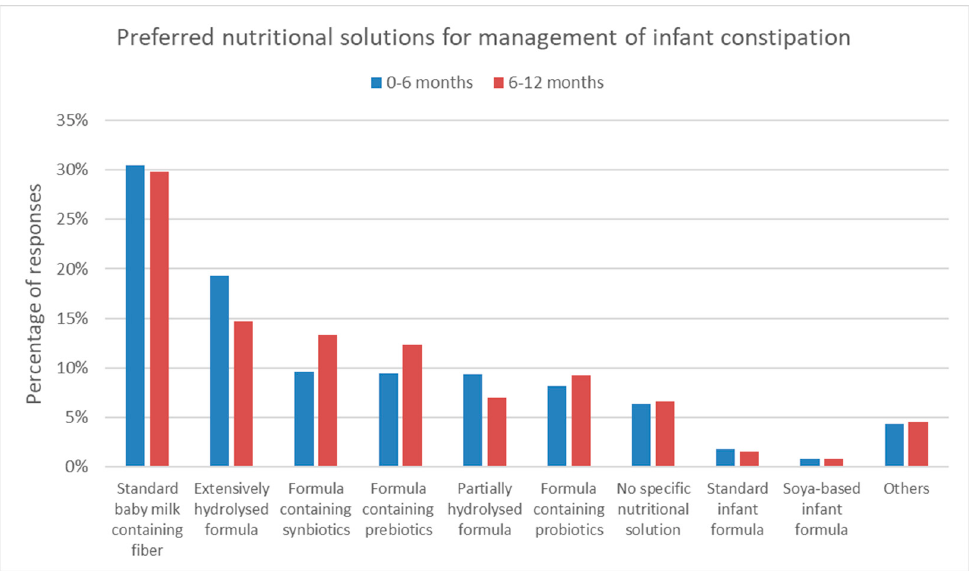
Figure 7. The preferences of HCPs for nutritional solutions in the management of FC in infants.